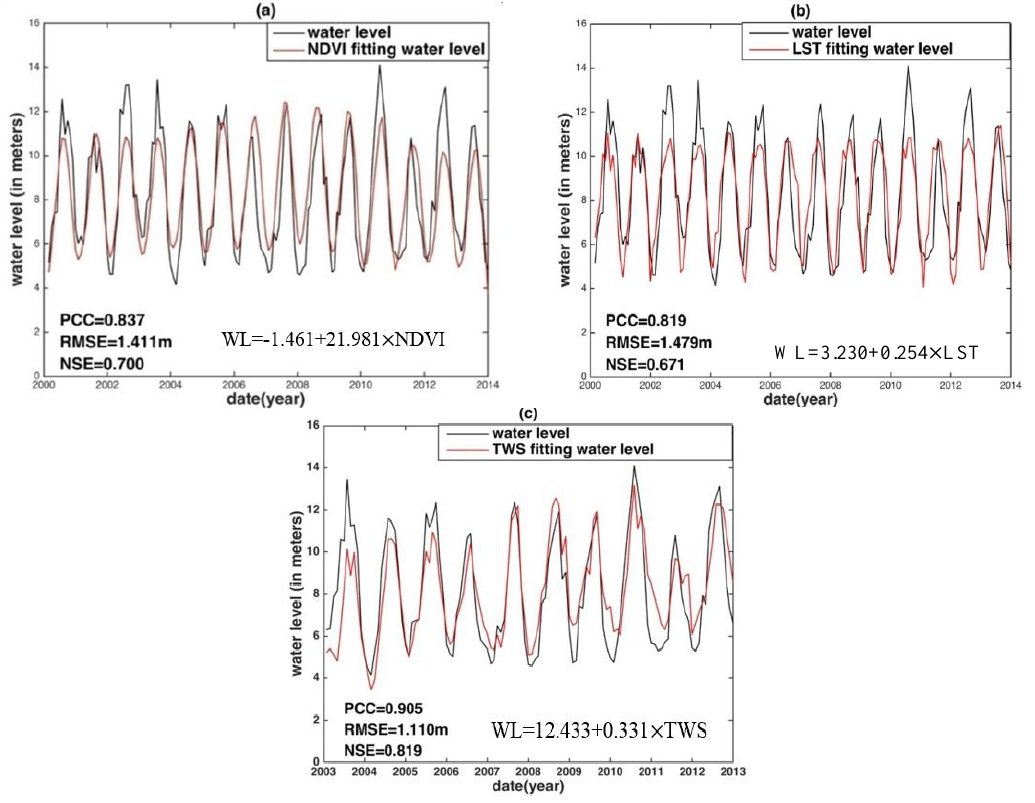
Figure 6. Water level reconstruction at ( a ) Datong station based on NDVI; ( b ) Land Surface Temperature (LST); and ( c ) TWS.